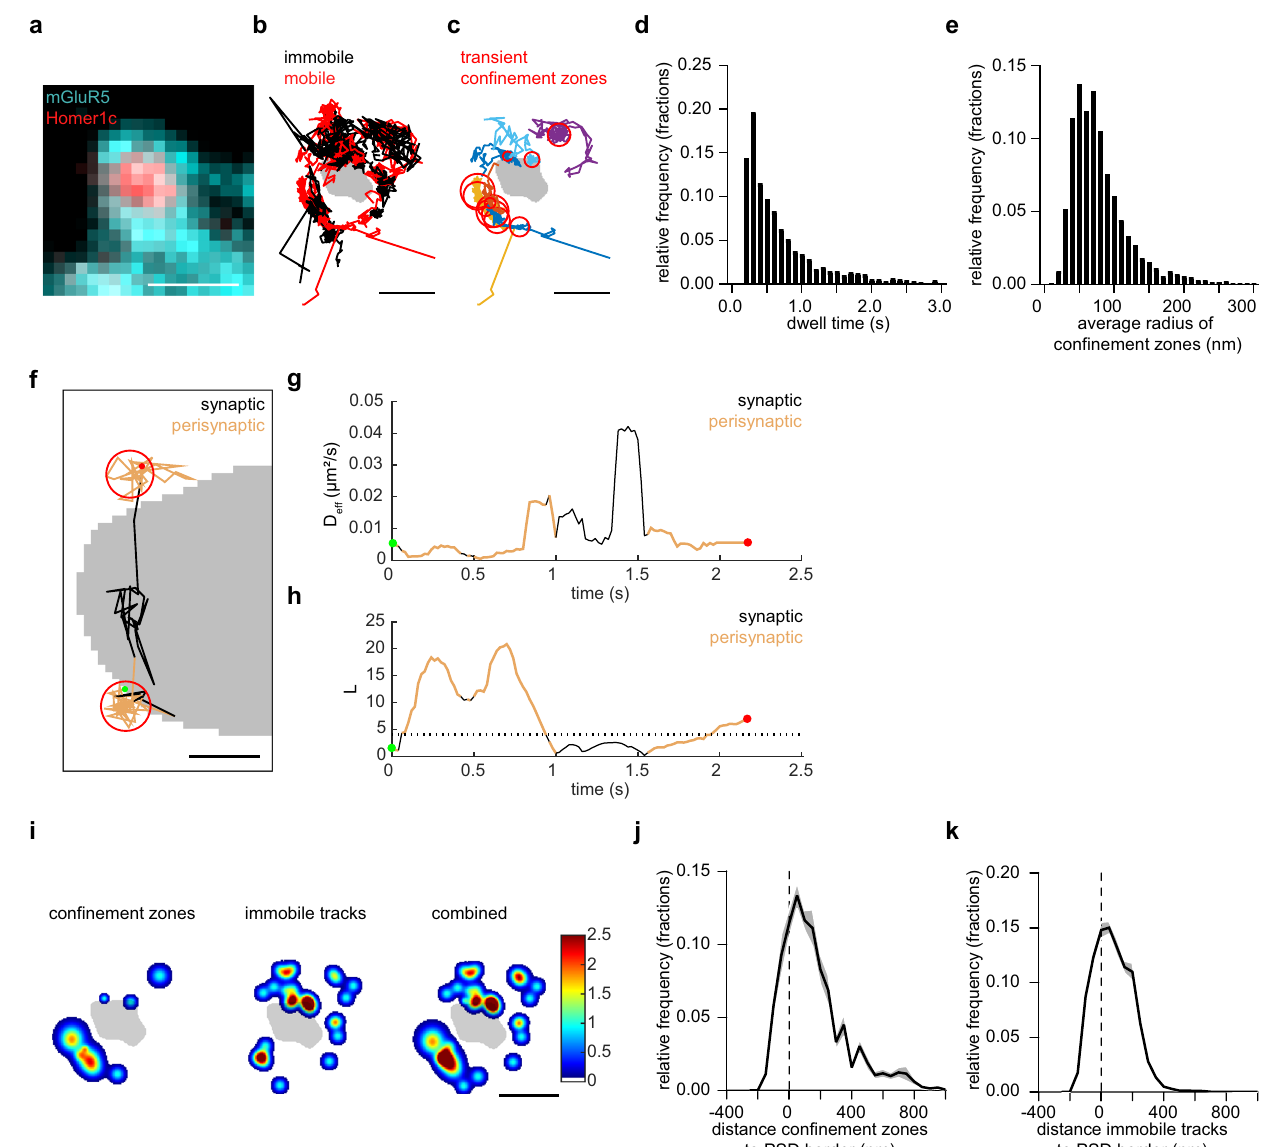
Fig. 4 | mGluR5 is transiently con fi ned, but also immobilized at the perisy- naptic zone.a Wide fi eldimage of a dendritic spine expressing SEP-mGluR5 (cyan) and Homer1c-mCherry (red). (larger ROI shown in Fig. S4a). Scale bar, 1 µ m. b The same spine as in a showing immobile (black) and mobile (red) SMTs of mGluR5 relativetotheHomer1cPSDmask(largerROIshowninFig.S4b).Scalebar,500nm. c Transient con fi nement zones (red circles) of the mobile trajectories (random colors) shown in B (larger ROI shown in Fig. S4f). Scale bar, 500nm. d Relative frequencyplotsofthedwelltime(s)and e averageradiusofcon fi nementzonesfor mGluR5 SMTs. f Example trajectory (assigned to perisynaptic fraction) that undergoes transient con fi nement in the perisynaptic zone, color-coded for enter- ingthe synapse (black) and perisynaptic zone (orange) and the con fi nementzones (red). The trajectory starts (green dot) and ends (red dot) in perisynaptic transient